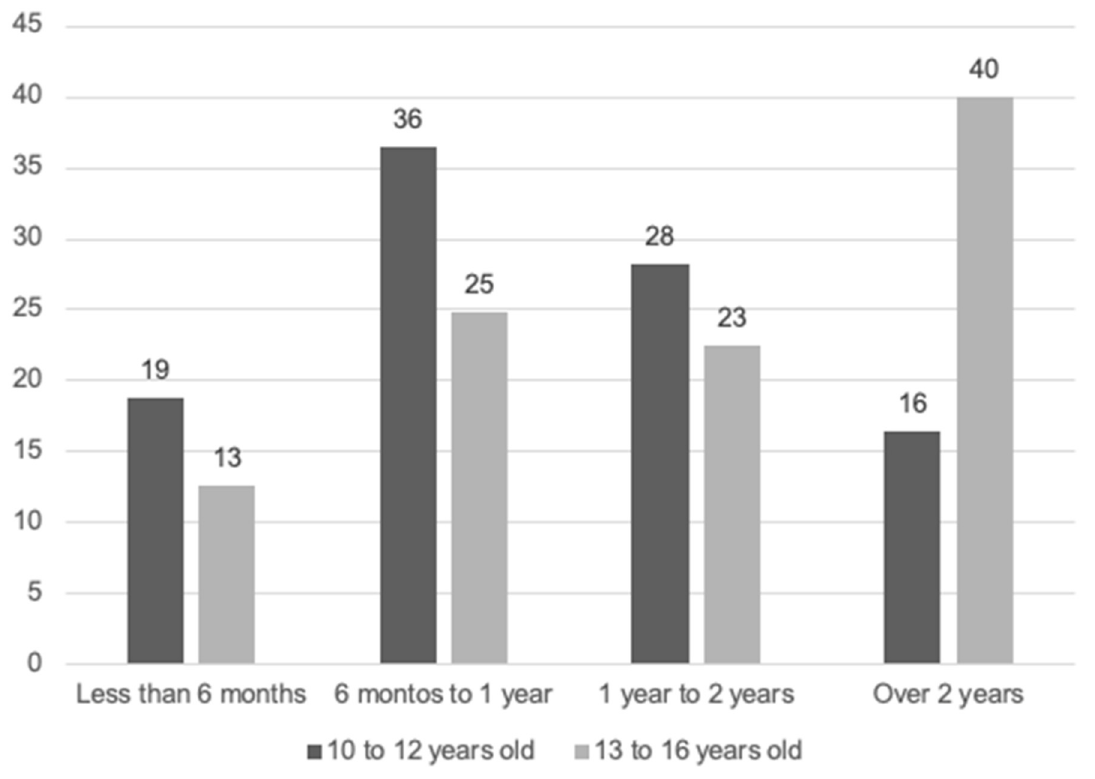
Figure 1. For how long respondents have been using TikTok (in percentage).